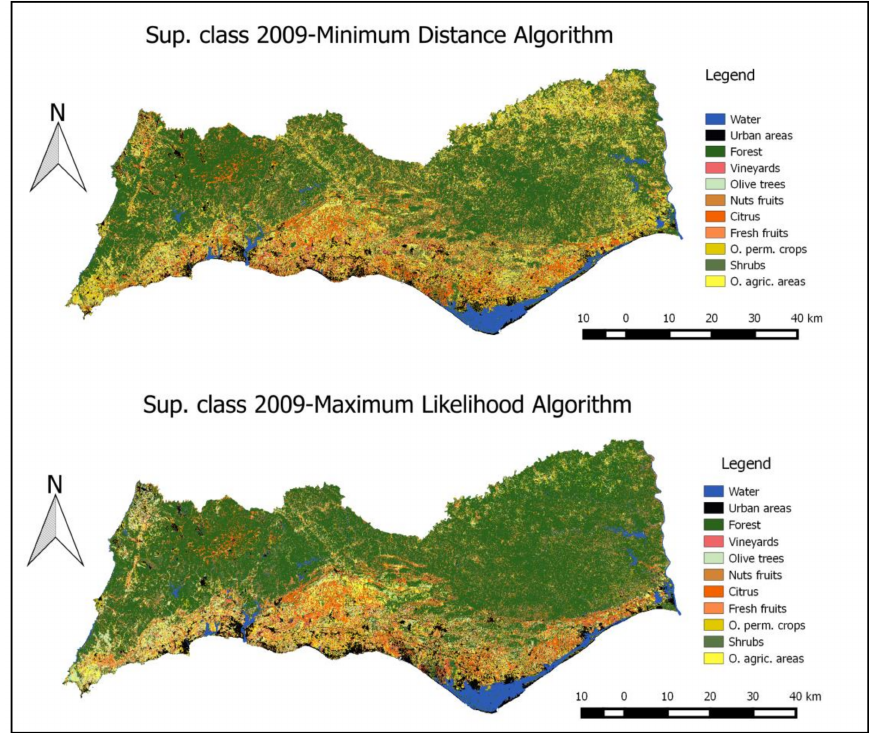
Figure 3. The supervised classification results for 2009 in the Algarve region; (source: model results). These results are presented at a 30 m × 30 m pixel level and are aggregated in a grid at a kilometric level. Examples of some “pixel” level estimates using the kilometric grid are presented in Table